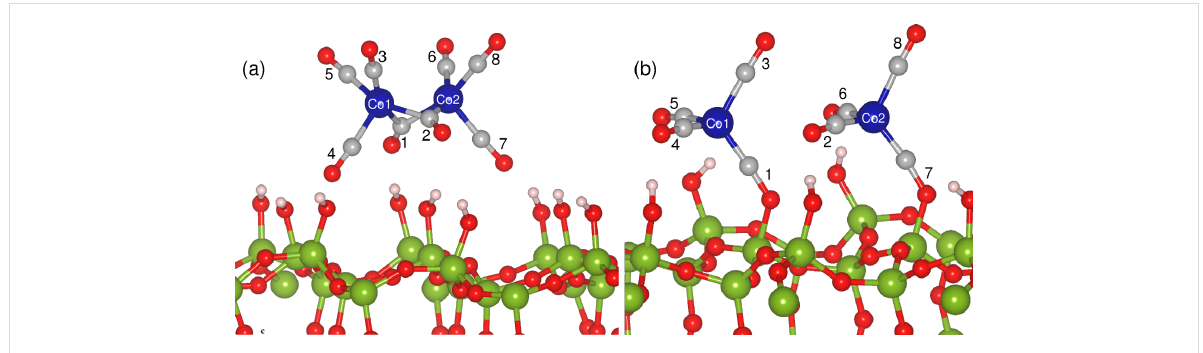
Figure 7: (a) Most stable structure of Co 2 (CO) 8 on the (a) FOH-SiO 2 and (b) POH-SiO 2 surfaces. The molecule dissociates on the POH surfaces into two Co(CO) 4 ions bonding to a terminal Si of the surface. Green, blue, red and grey spheres represent silicon, cobalt, oxygen and carbon atoms, res- pectively.